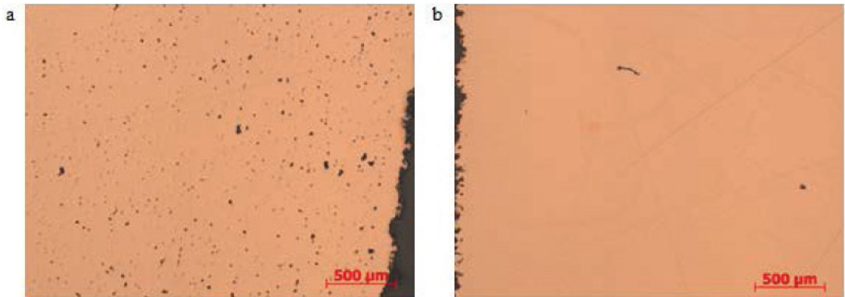
Figure 17. Sample micrographs indicating density improvement upon HIP, ( a ) Sintered Part, 1.88% porosity, ( b ) HIPed Part, 0.13%porosity calculated from image analysis. Adapted from [106] Elsevier, 2017.